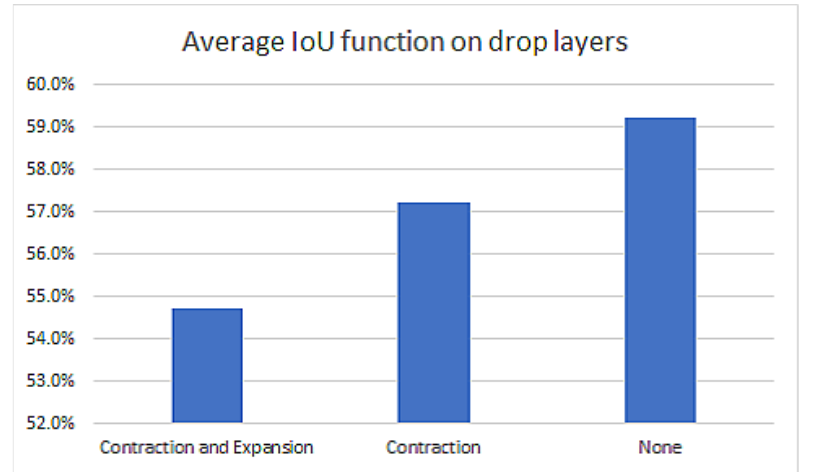
Figure 11. U-NET performance as a function of employed drop layers.